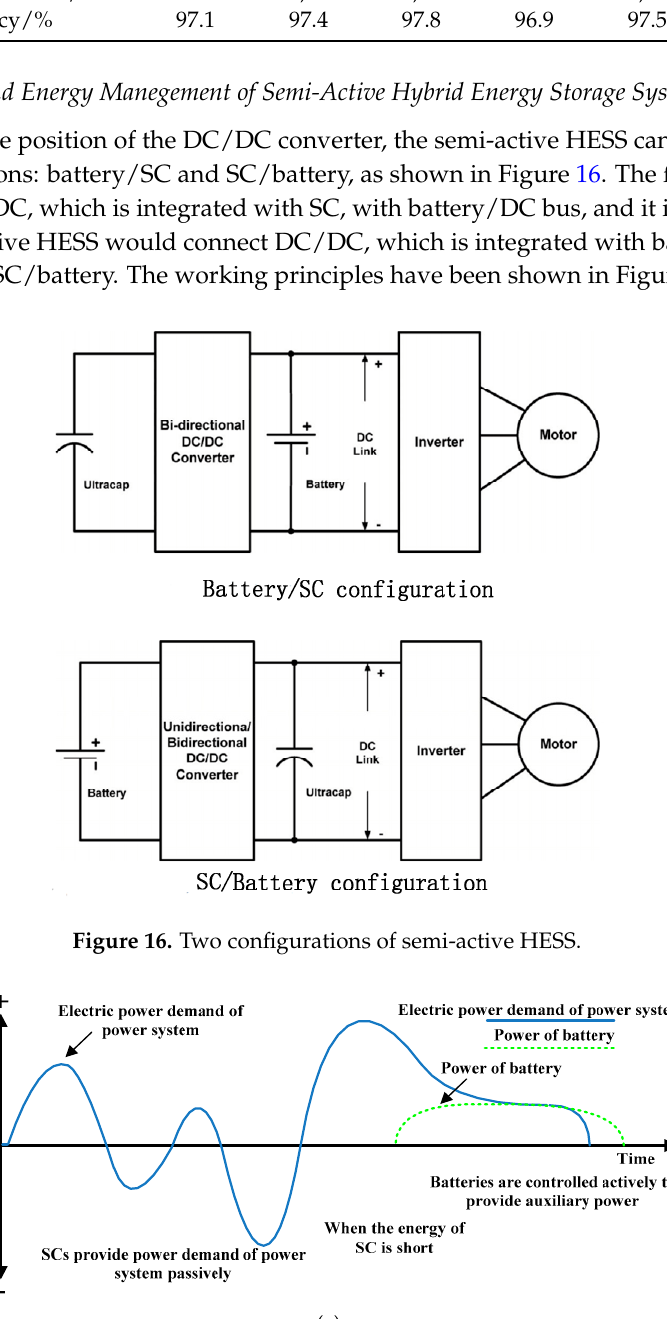
Figure 15. Structure of reversible boost DC/DC. IGBT: insulated gate bipolar transistor. Table 6. Characteristics of the reversible boost bridge DC/DC.